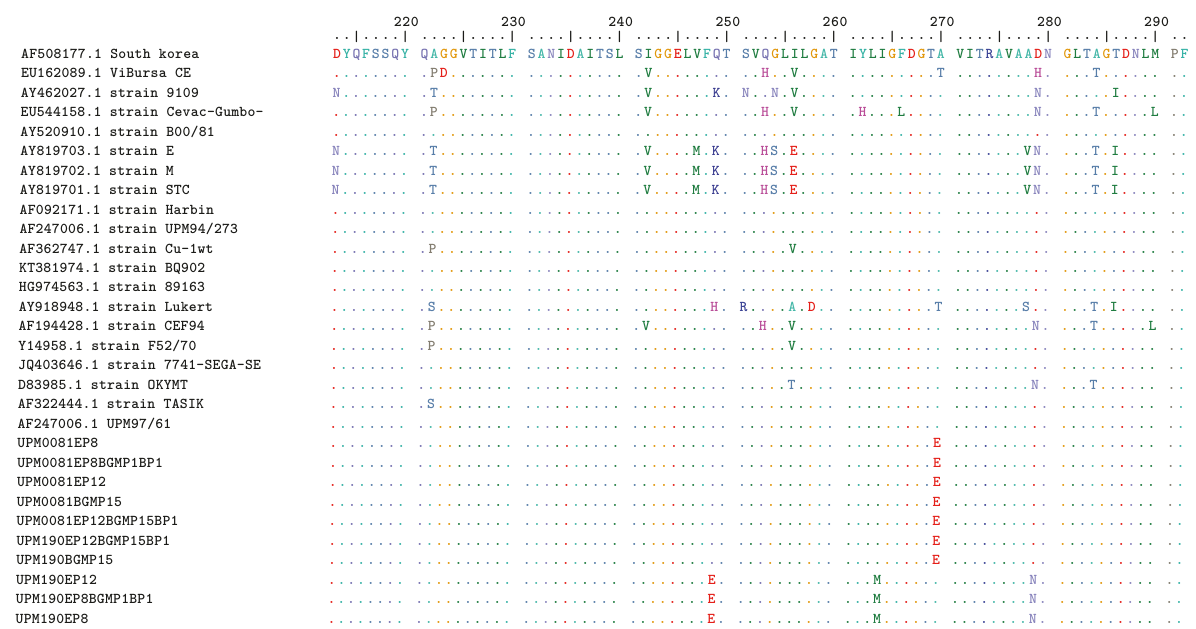
Figure 5: Comparison of amino acid sequences of bioreactor and BGM-70 propagated UPM0081 and UPM190. Protein alignment of bioreactor, BGM-70, and SPF egg passaged UPM190 and UPM0081 isolates with 30 reference sequences showing no amino acid changes between the original parental isolates and the bioreactor passaged isolates.